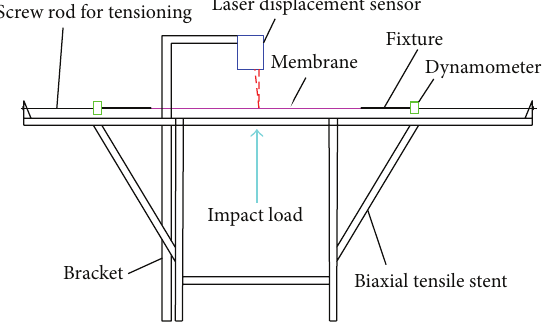
Figure 1: The schematic for